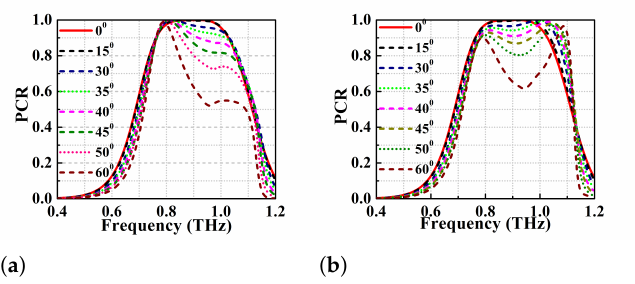
Figure 8. Angular stability performance analysis of the proposed PC ( a ) schematic representation of the metasurface under oblique angle incidence, angular stability at l 1 = 117 µ m ( b ) TE mode ( c ) TM mode.